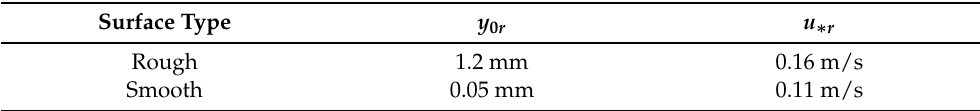
Table 2. The friction velocity ( u ∗ r ) and the aerodynamic surface roughness lengths ( y 0 r ) of the wind tunnel data.